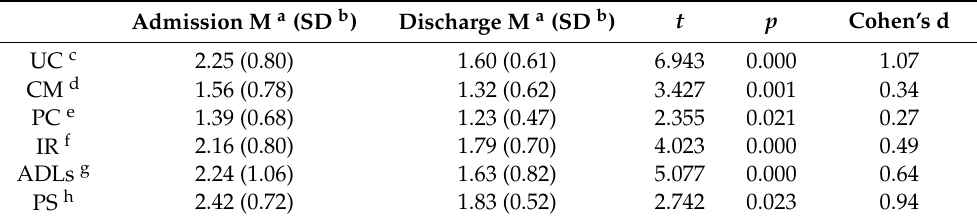
Table 1. Simple effects of time on the different factors of the World Health Organization Disability Assessment Schedule (WHODAS) according to the patient’s self-evaluation.